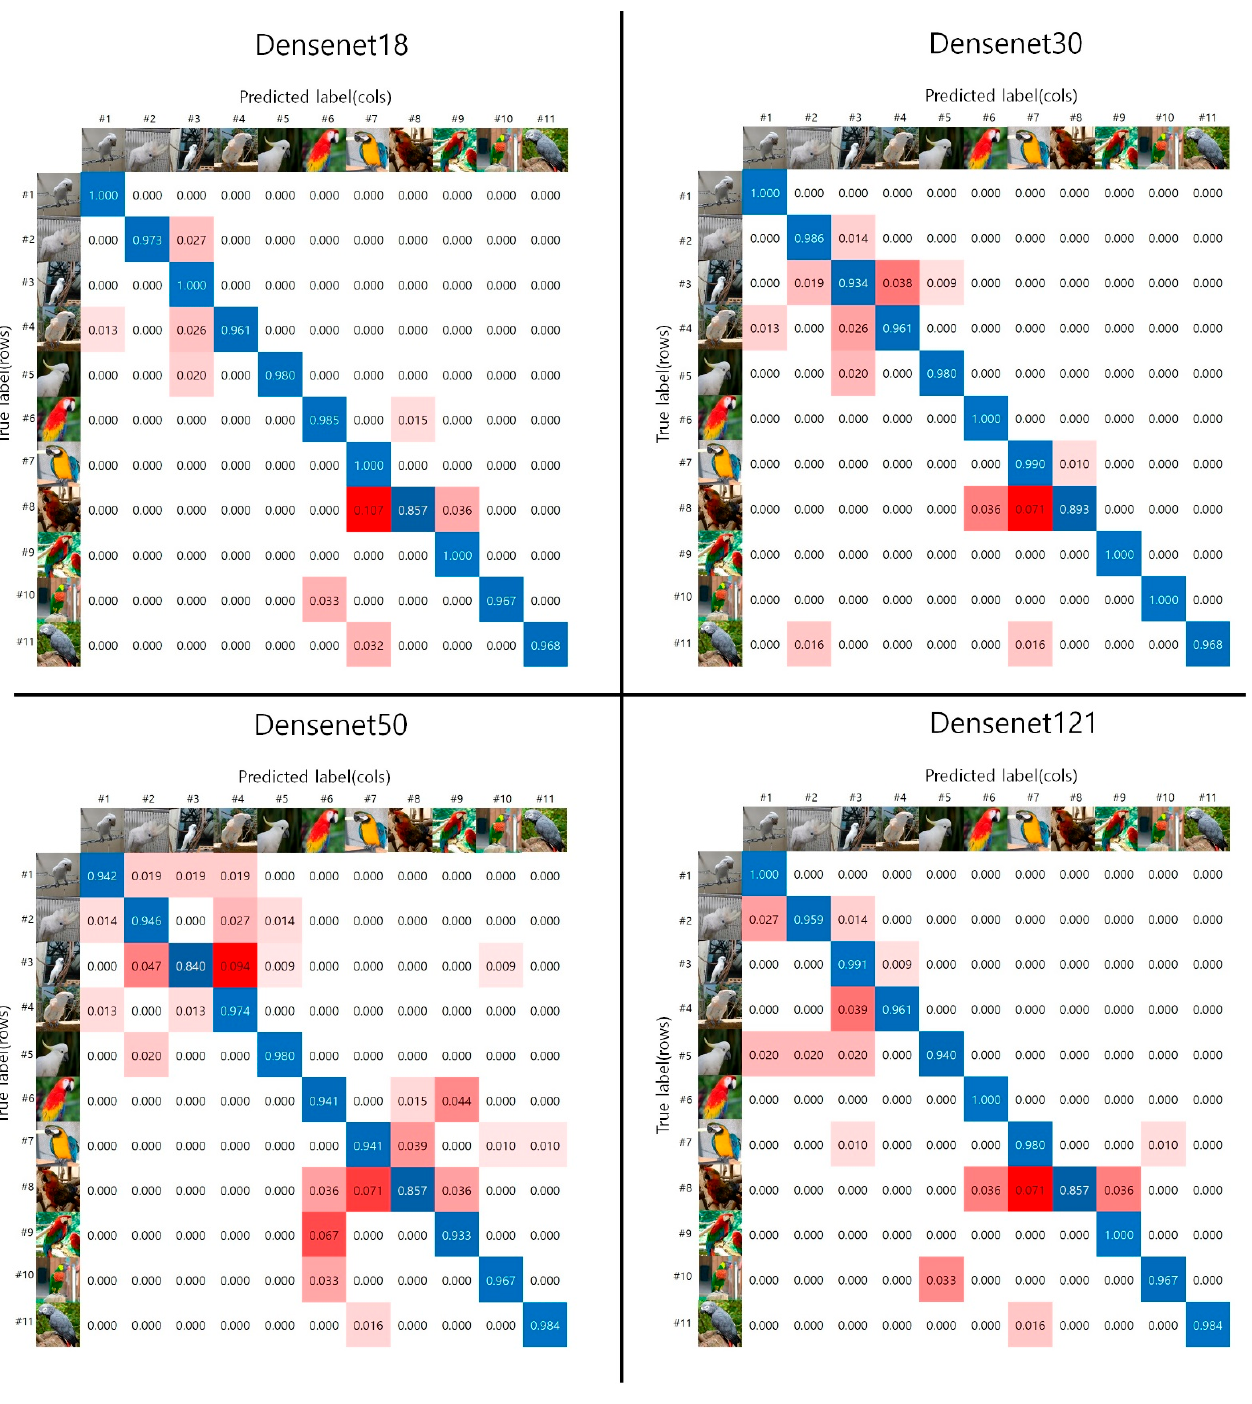
Figure 5. The confusion matrices of the 11 parrot species for each model proposed. The on-diagonal results (blue tones) are the correct predictions, whereas the red tones are the incorrect predictions.